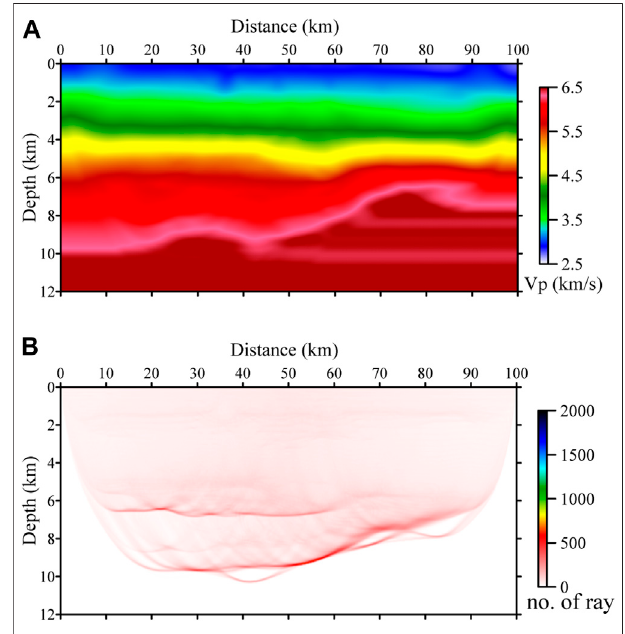
FIGURE 9 | The inverted velocity model (A) with Type-I modi fi ed geometry and (B) its ray density map. The maximum offset of the normal geometry part is 10 km. Two extra sources were excited at both sides of the receiver array.